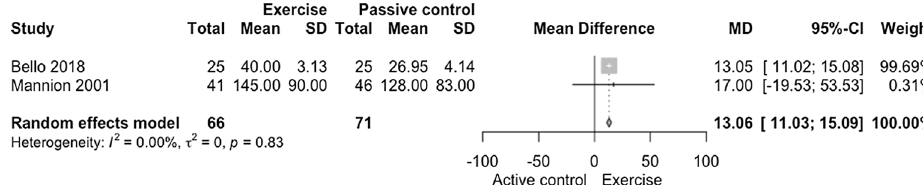
Figure 2. Forest plot of the comparison of exercise vs. active control on the EMG. Mannion et al. (2001) 41 : Training Devices versus Multimodal Physical therapy—Electromyogram (Hz). Bello (2018) 76 : Stabilization exercises versus Treadmill walking exercise—Electromyogram